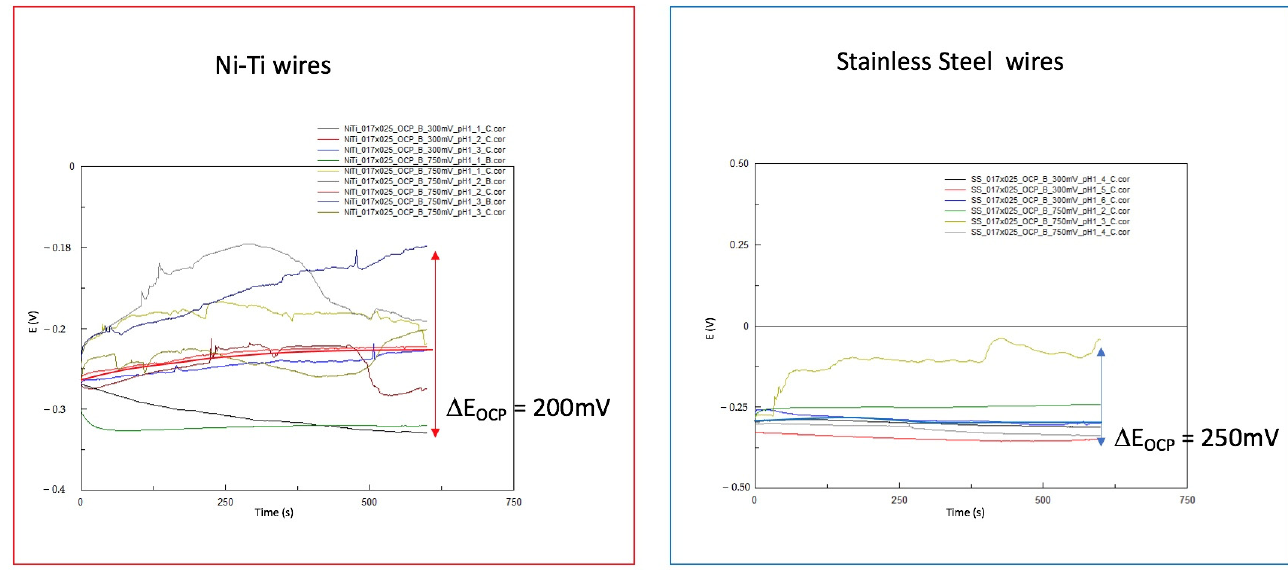
Figure 12. A collection of OCP E versus t curves of NiTi and SS wires after CV—aging of alloys—in Ringer’s solution at pH = 1, RT; the potential differences between the highest and lowest values are marked with red and blue arrows.